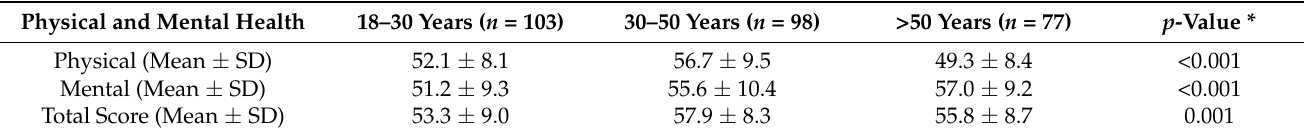
Table 4. Comparison of physical and mental quality of life scores based on the SF-12 questionnaire stratified by age group.